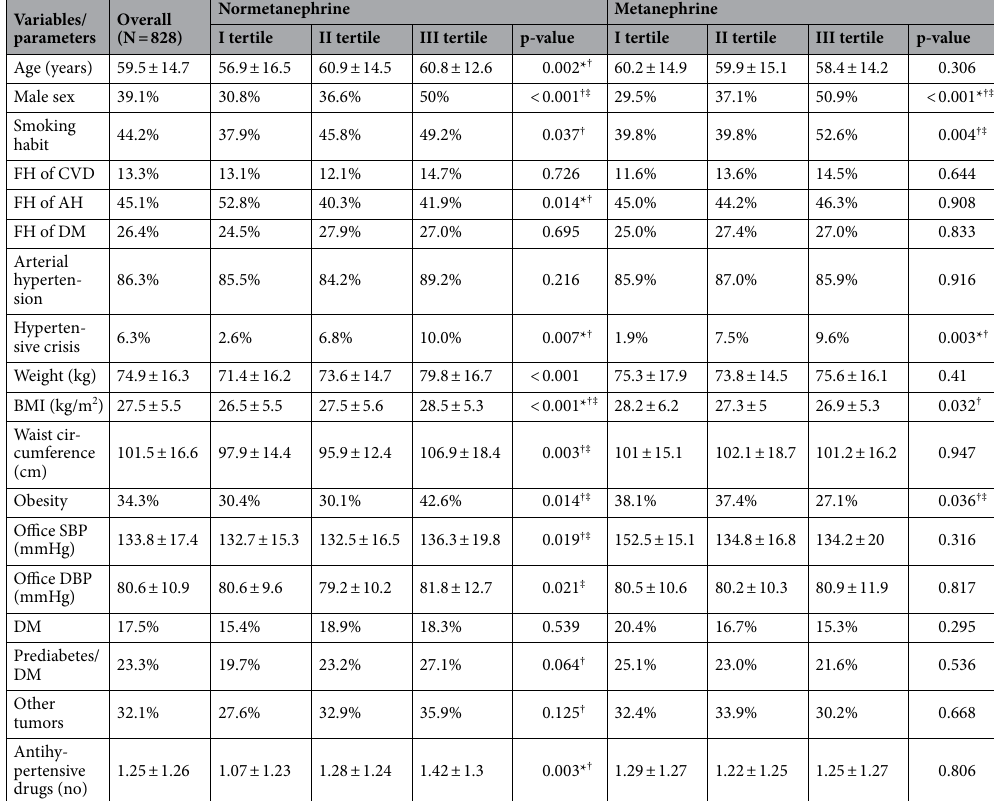
Table 1. Clinical variables/parameters according to tertiles of normetanephrine and metanephrine levels. AH, arterial hypertension; BMI, body mass index; CVD, cardiovascular disease; DBP, diastolic blood pressure; DM, diabetes mellitus; FH, familial history; SBP, systolic blood pressure. The table shows p-values of the statistics analyzing differences between the three tertiles. *Significant difference between I tertile and II tertile. † Significant difference between I tertile and III tertile. ‡ Significant difference between II tertile and III